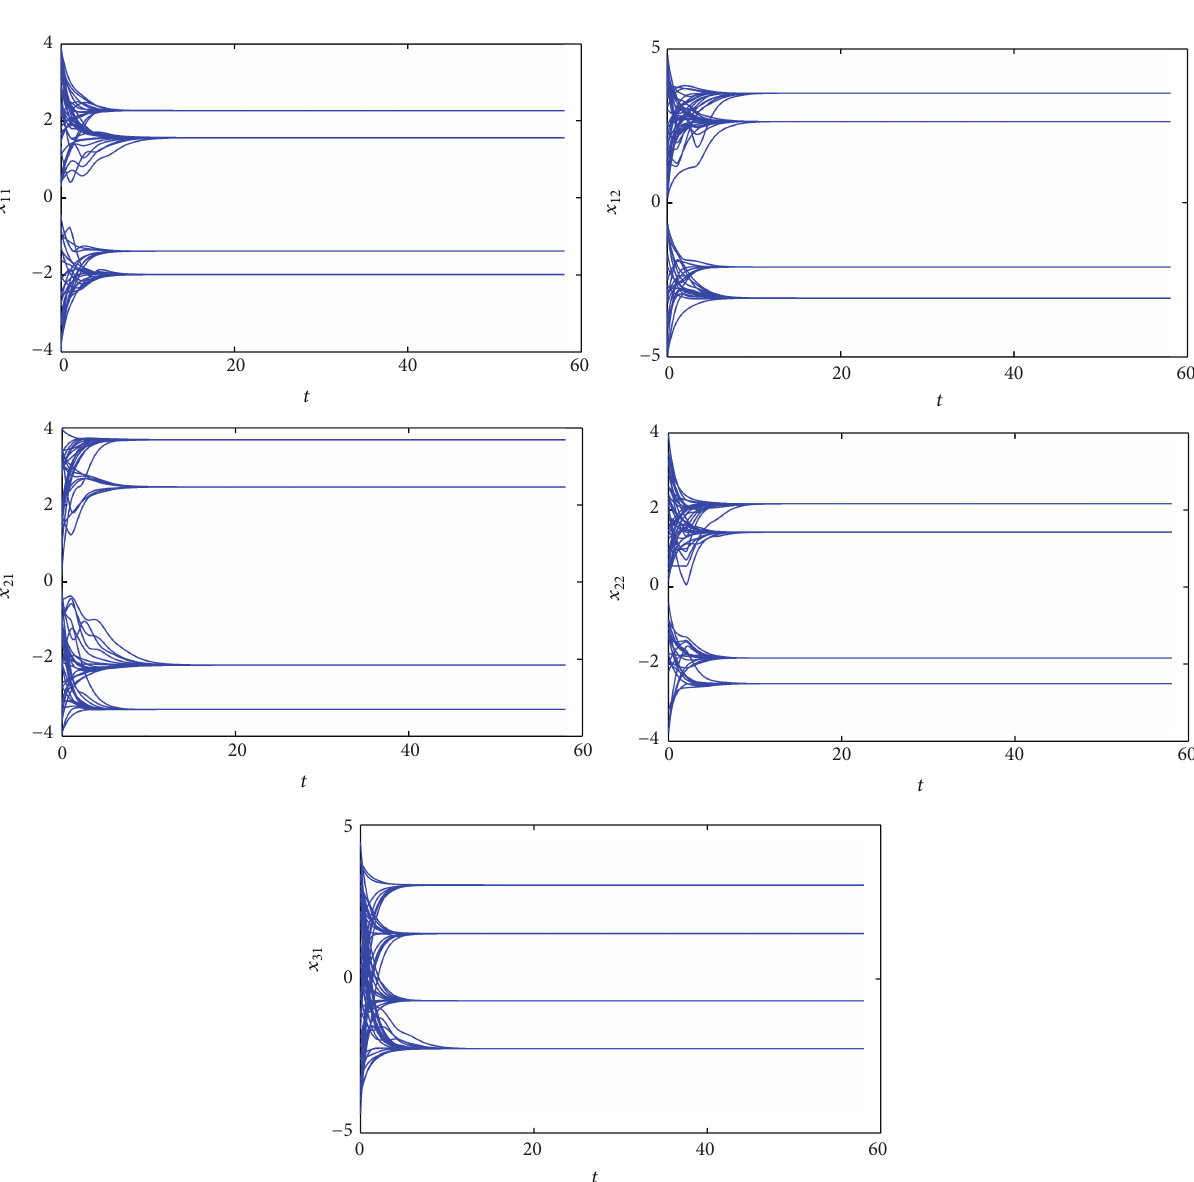
Figure 2: The exponential stability of 4 equilibria of the MAM neural network